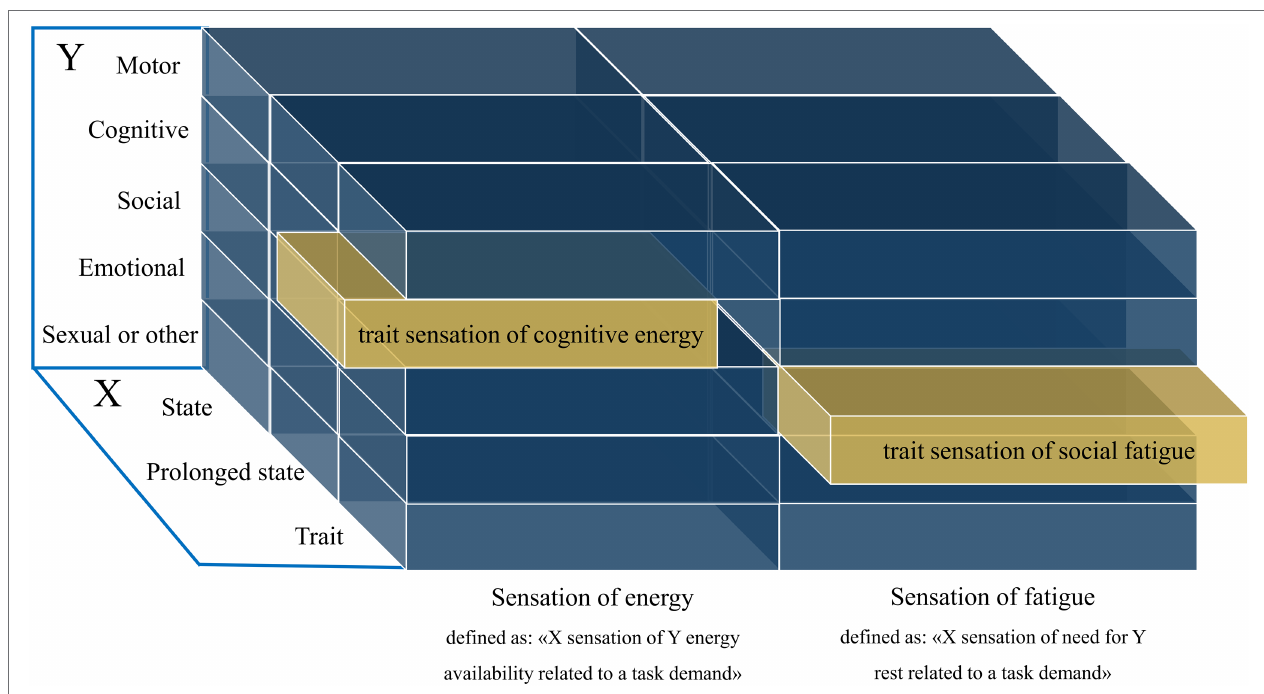
FIGURE 1 | Visualization of the definition of fatigue and energy sensations. The X-axis contains the state (in this moment), prolonged state (general tendency within a defined time period), and trait (an overall disposition) dimensions. The Y-axis contains the possible domains of sensations of fatigue or